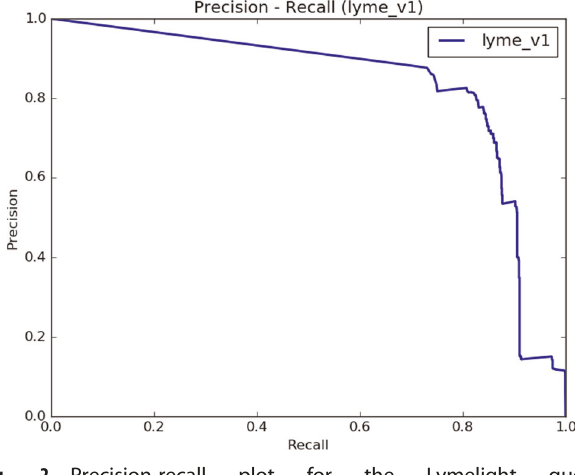
Fig. 2 Precision-recall plot for the Lymelight query classi fi cation